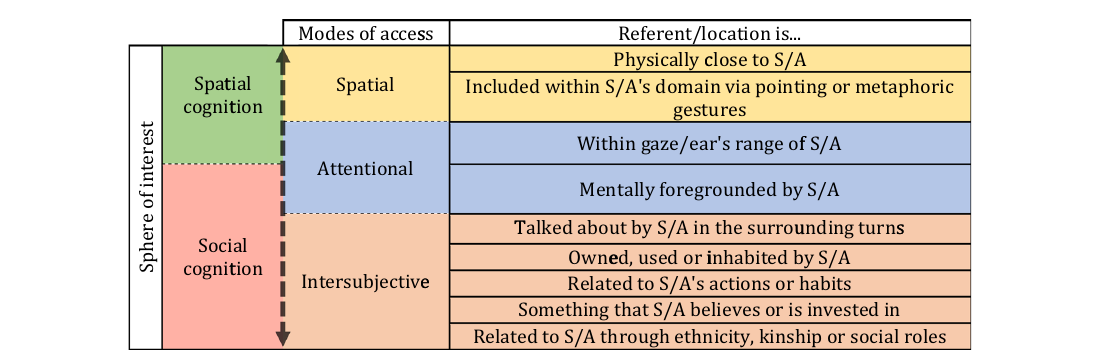
Table 3: Modes of access in Phola deixis; S/A = the speaker or the